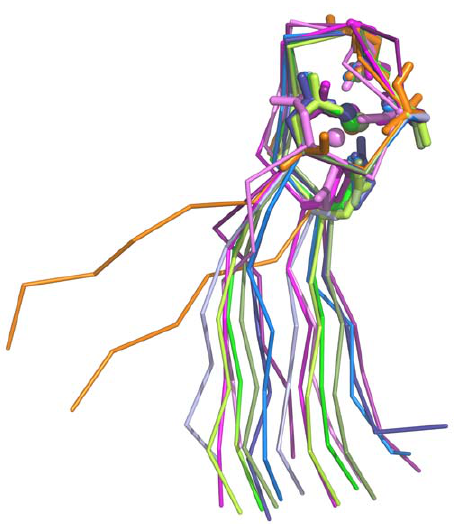
Figure 4. Comparison of calcium blades and their flanking b - strands. Backbone is shown as ribbon, side chains that interact with metal as sticks and the metal ions as small spheres. The structures are coloured as follows: integrin (PDB code 1jv2; three examples) in shades of pink, lectin (2bwr; three examples) in shades of green, rhamnoga- lacturonan lyase (2z8r; three examples) in shades of blue and PilY1